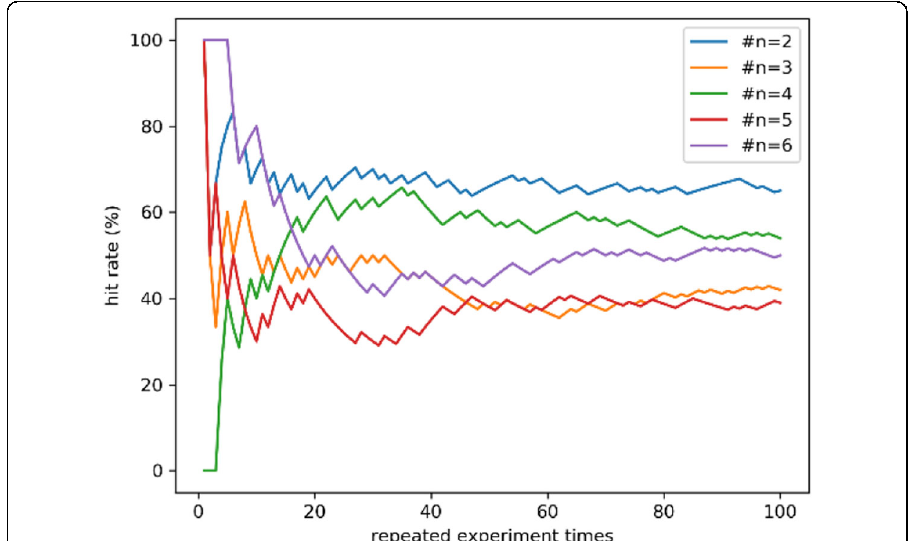
Fig. 6 The comparison of algorithm hit